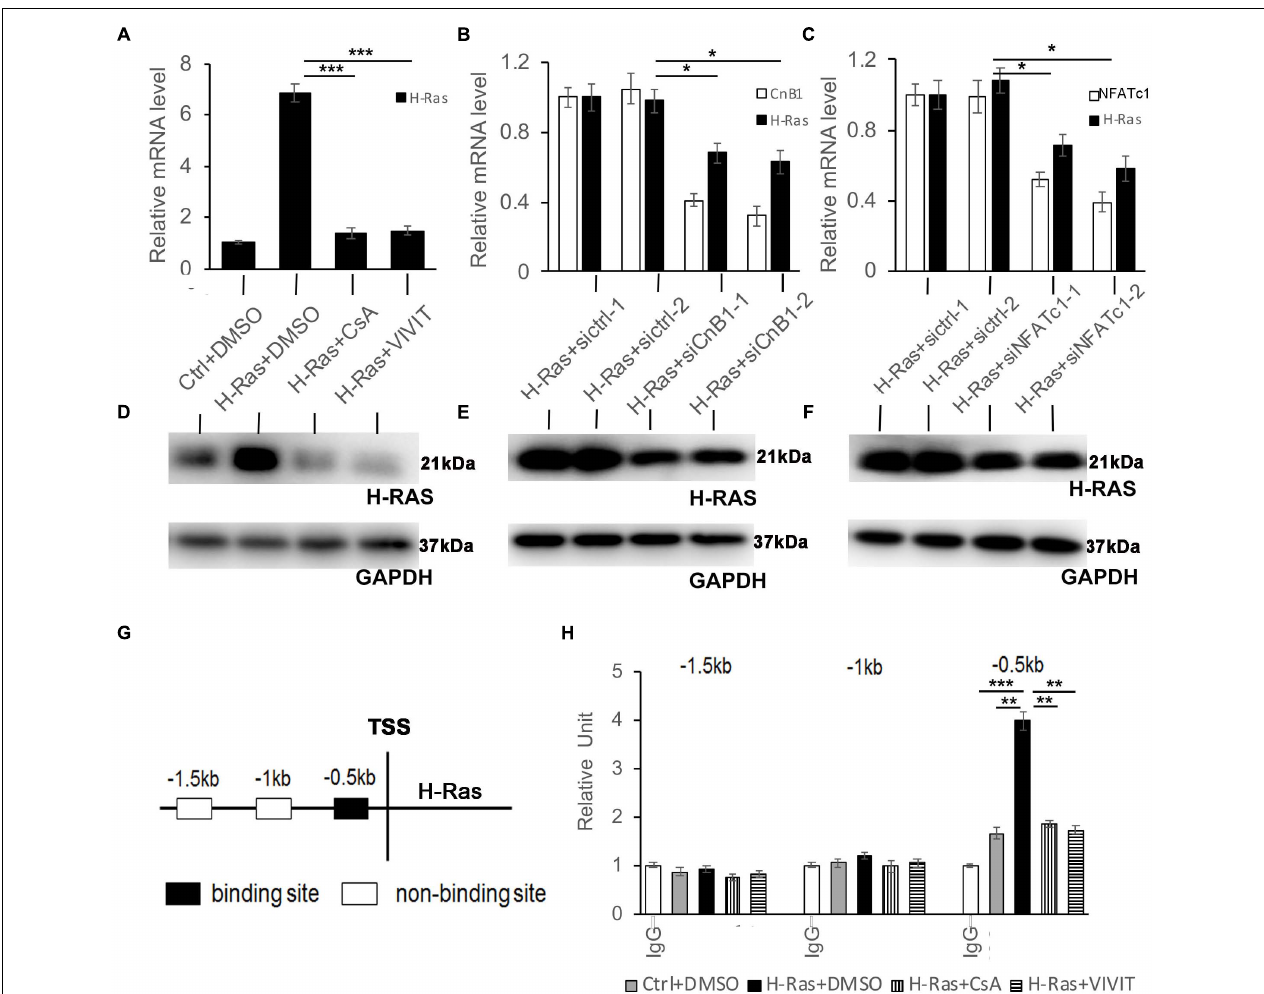
FIGURE 6 | NFATc1 regulates H-Ras expression in human keratinocytes overexpressing H-RasA. Human keratinocytes were infected with a H-Ras G 12 V expressing or a control retrovirus and were then treated with the calcineurin/NFAT inhibitors CsA, VIVIT, or DSMO as a negative control for 24 h, then were collected for quantitative RT-PCR analysis of H-Ras expression. (B-C) Human keratinocytes were transfected with two independent siRNAs of CnB1 (siCnB1-1 and siCnB1-2) in panel (B) or NFATc1 (siNFATc1-1 and siNFATc1-2) in panel (C) or scramble siRNAs (siCtrl) in both panels (A,B) as a control 2 days after transfection, the cells were infected with a H-Ras G 12 V expressing or a control retrovirus, and 24 h later, the treated cells were collected for quantitative RT-PCR analysis of CnB1 (B) or NFATc1 (C) , and H-Ras expression. (D–F) Western-blot analysis of H-Ras protein levels in cells from panels (A–C) , respectively. GAPDH as loading control. (G,H) Three potential binding sites located upstream of the H-Ras transcriptional start site (TSS) as indicated in panel (G) were analyzed by CHIP assays, and CHIP products derived from human keratinocytes with different conditions as labeled were analyzed by RT-PCR in panel (H) . All experiments were carried out three times, and error bars represent means ± SD; p values are indicated with “*,” * p < 0.05, ** p < 0.01, and *** p < 0.005 when comparing two corresponding groups indicated with the black lines by Student’s t